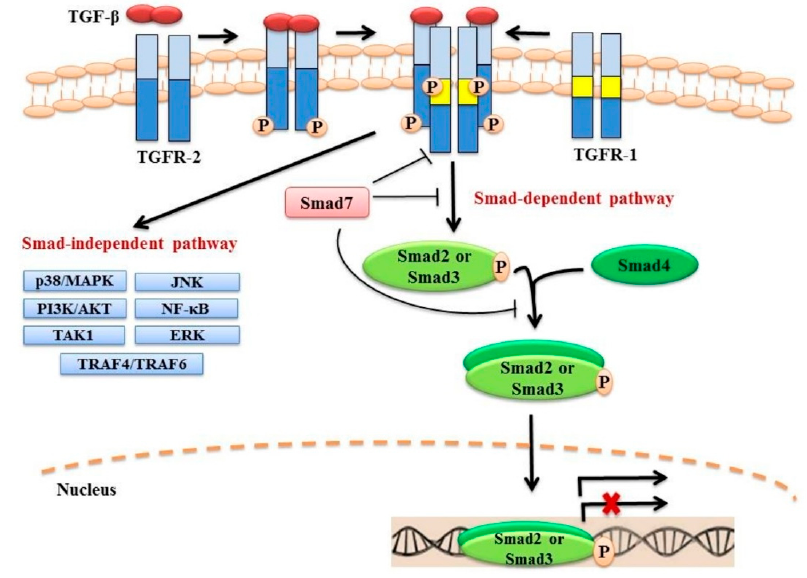
Figure 1. The TGF- β signalling pathway. Binding of an activated TGF- β ligand to TGFR-2 recruits and